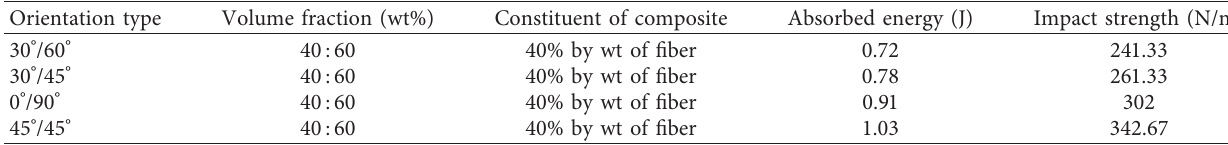
Table 2: Sample orientation, volume fraction, and their property.